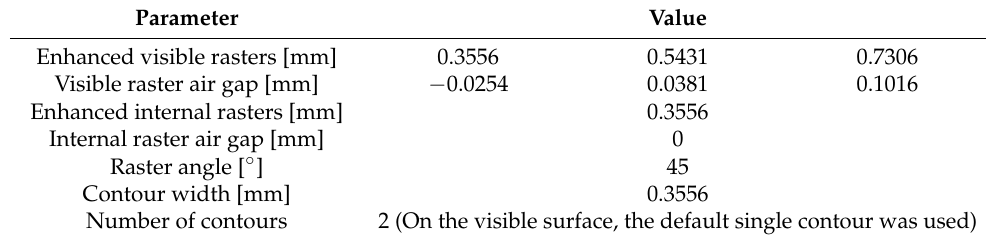
Figure 2. Preliminary 3D printing tests: ( a ) bad and ( b ) good surface quality results. Table 2. FDM process parameters.